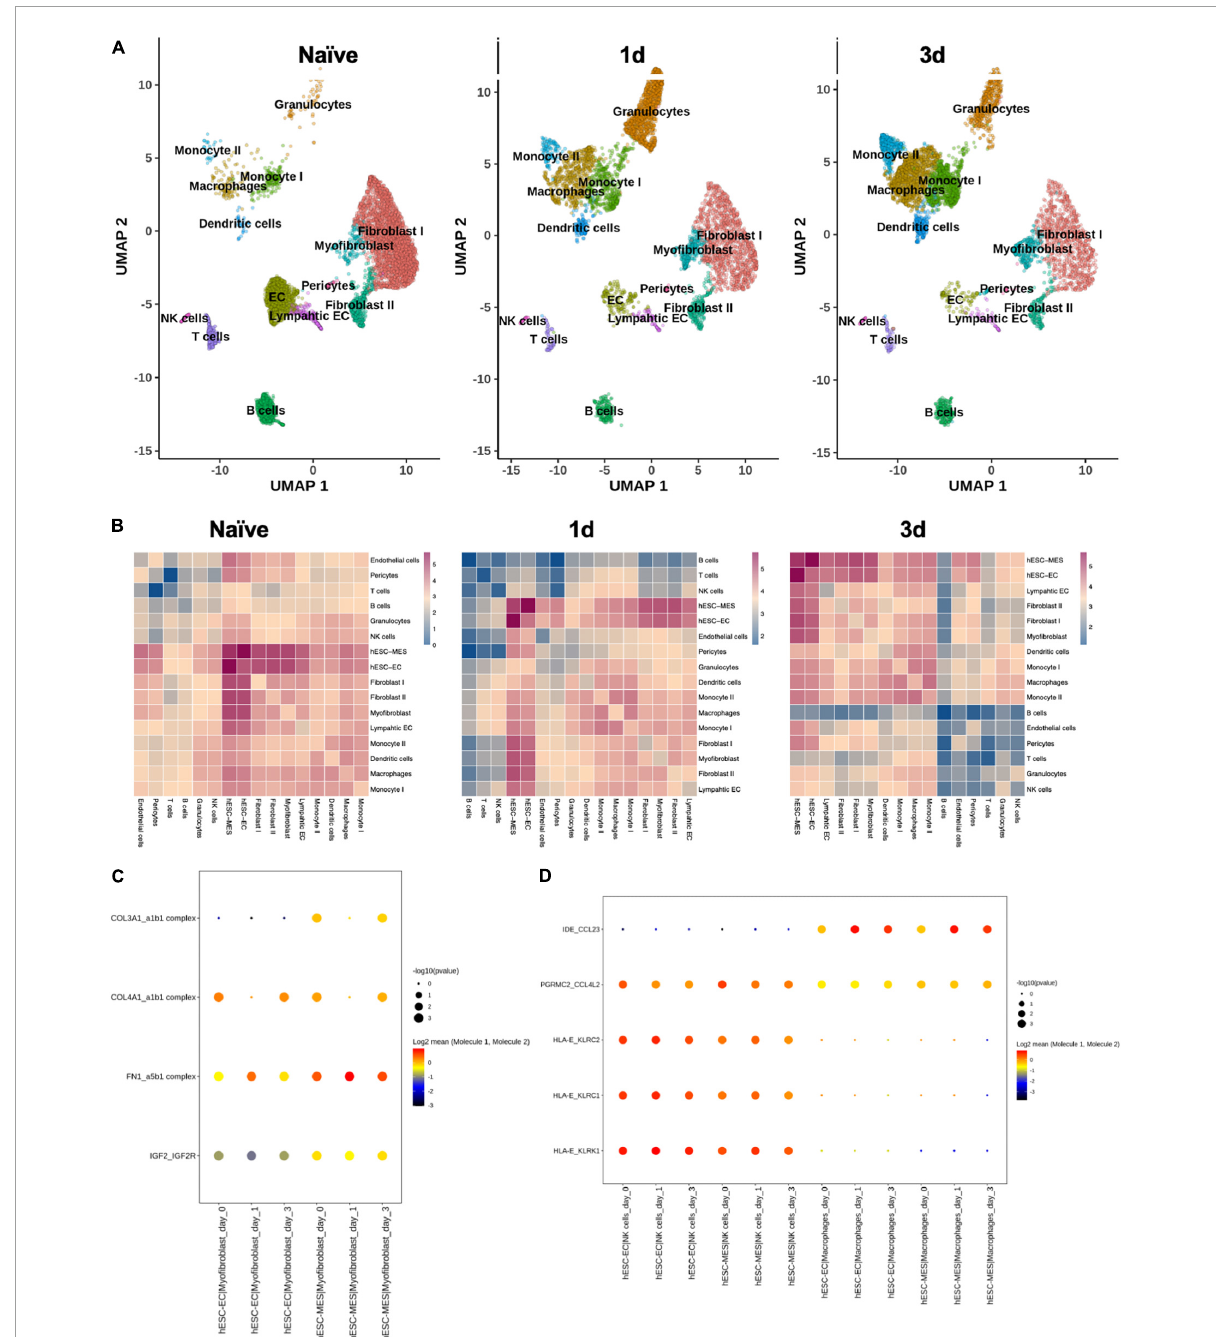
FIGURE6 Ligand–receptor interactions between hESC-ECP constituents and resident cardiac populations. (A) UMAP projection of clusters identified from cardiomyocyte-free scRNA-seq data of C57BL/6J hearts taken either prior to CAL (naive), or 1 or 3 days post-CAL. (B) Ligand–receptor interaction (LRI) analysis between day eight hESC-ECP populations and resident cardiac populations at each timepoint. Heatmaps illustrate log 10 (number of predicted LRI) between each population. Dot plots of LRIs between hESC-ECP populations and (C) myofibroblasts and (D) NK and